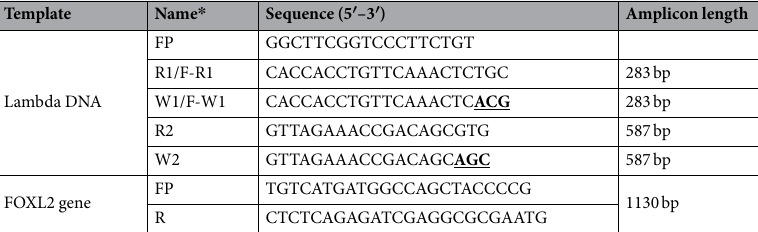
Table 1. Primers for Lambda and FOXL2 templates. * In primer names, FP indicates the forward primer. R and W indicate matched reverse primer and mismatched reverse primer, respectively. The letter of “F-” before the primer name indicates that primer was labeled with TAMRA fluorochrome at 5 ′